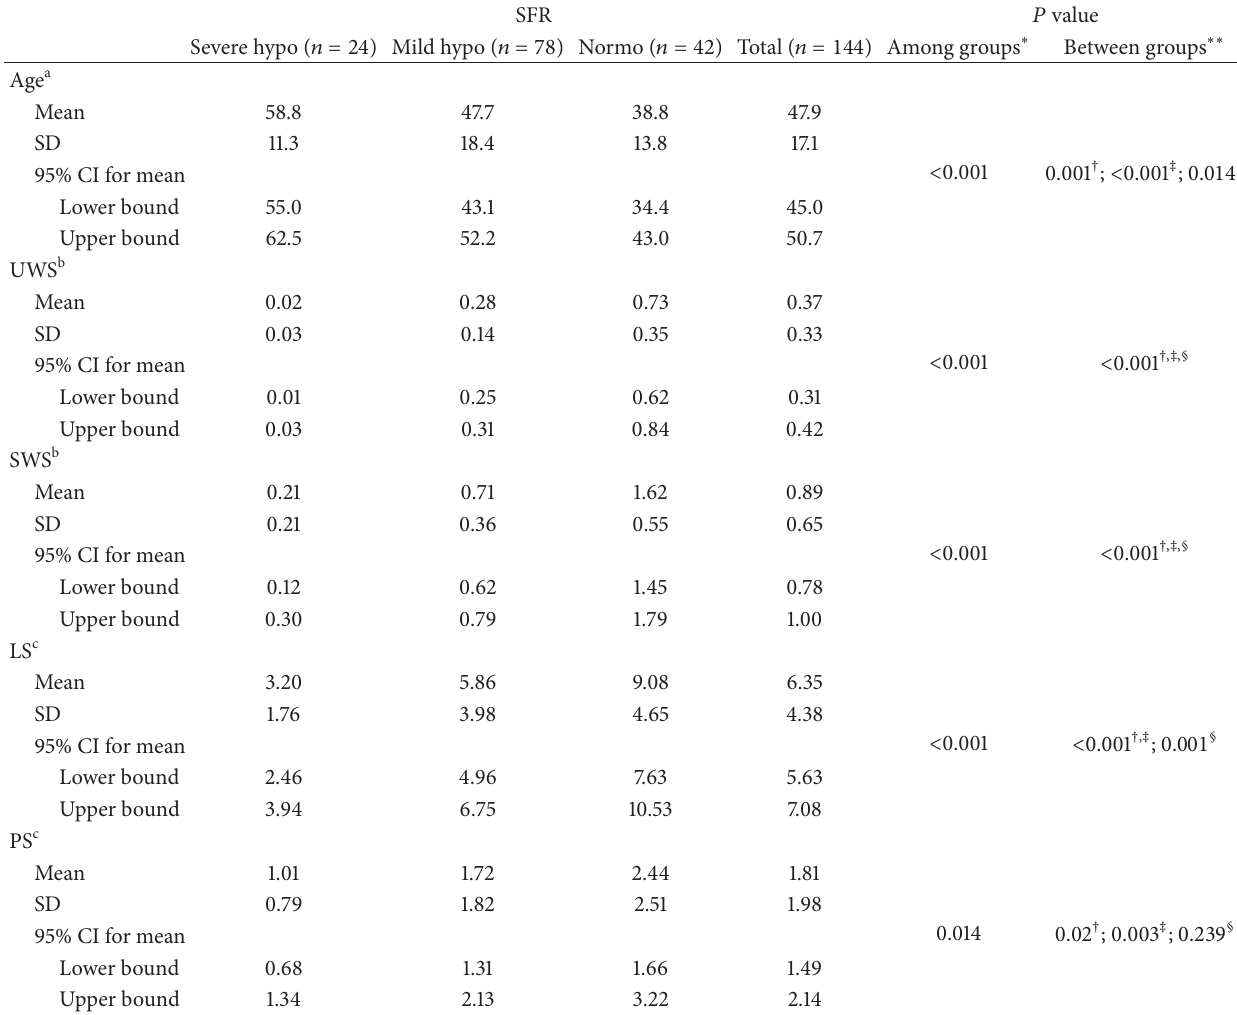
Table 2: Age and secretion rates of major and minor salivary glands among groups. SFR 𝑃 value